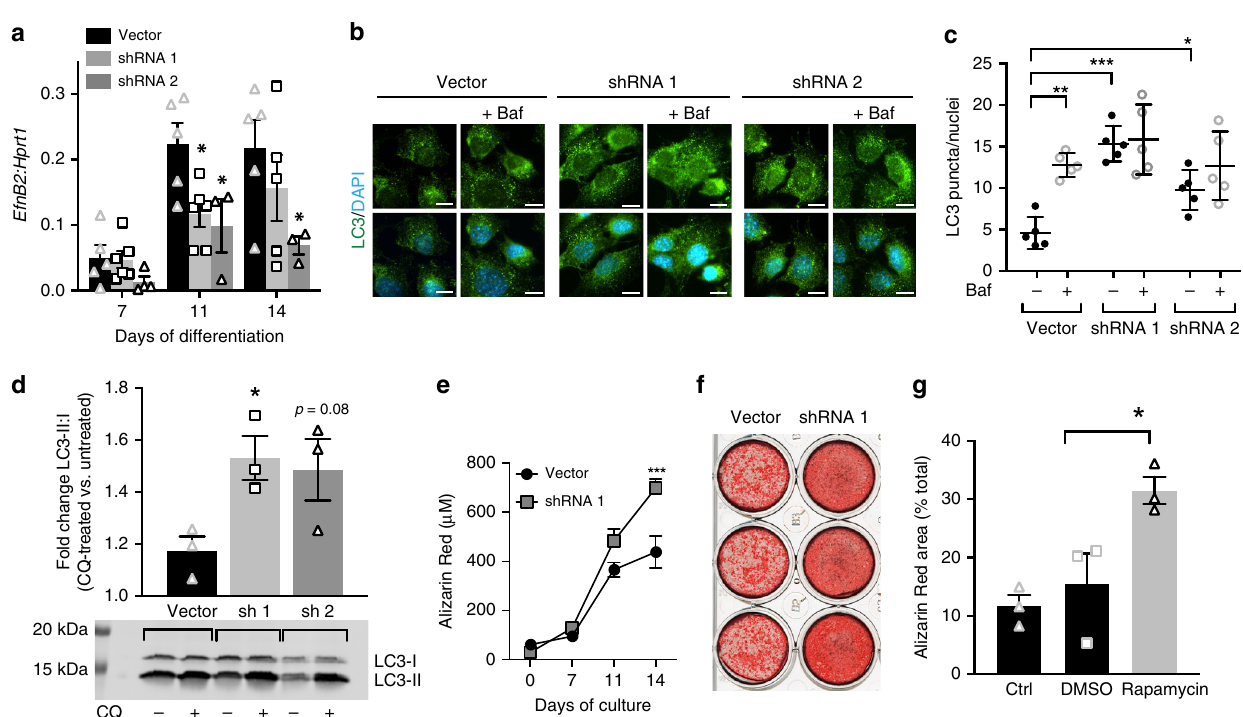
Fig. 5 Con fi rmation of increased autophagy and mineralization in EphrinB2-de fi cient Ocy454 osteocytes, and effect of autophagy on mineralization. a Efnb2 stable knockdown (short hairpin RNA (shRNA) 1 and shRNA 2) in Ocy454 cells differentiated for 7, 11, and 14 days, mean ± SD, 3 – 6 replicates, representative of three independent cultures; * p < 0.05 vs. vector by Student ’ s t test. b , c Autophagosomes (LC3 punctae) in Efnb2 -de fi cient Ocy454 cells; ba fi lomycin (Baf) treatment (50 nM for 2 h) was used to block autophagosome degradation. Data shown are mean ± SD, fi ve replicates, representative of three independent cultures; * p < 0.05; *** p < 0.001 as indicated by one-way analysis of variance (ANOVA). Scale bar = 10 μ m d Fold change of LC3-II:I ratio in Efnb2 shRNA knockdown cells treated with chloroquine (CQ) for 4 h compared to basal levels of each shRNA construct. Data are represented as mean ± SEM, three replicates, representative of three independent cultures, * p < 0.05 vs. vector control by one-way ANOVA. e , f Alizarin Red stain for mineralization in Ocy454 cells with vector or Efnb2 shRNA 1 knockdown, grown under mineralizing conditions for 14 days. Data shown are mean ± SD, four replicates, representative of three independent cultures; *** p < 0.001 vs. vector by two-way ANOVA; f Alizarin Red-stained wells at day 14, showing